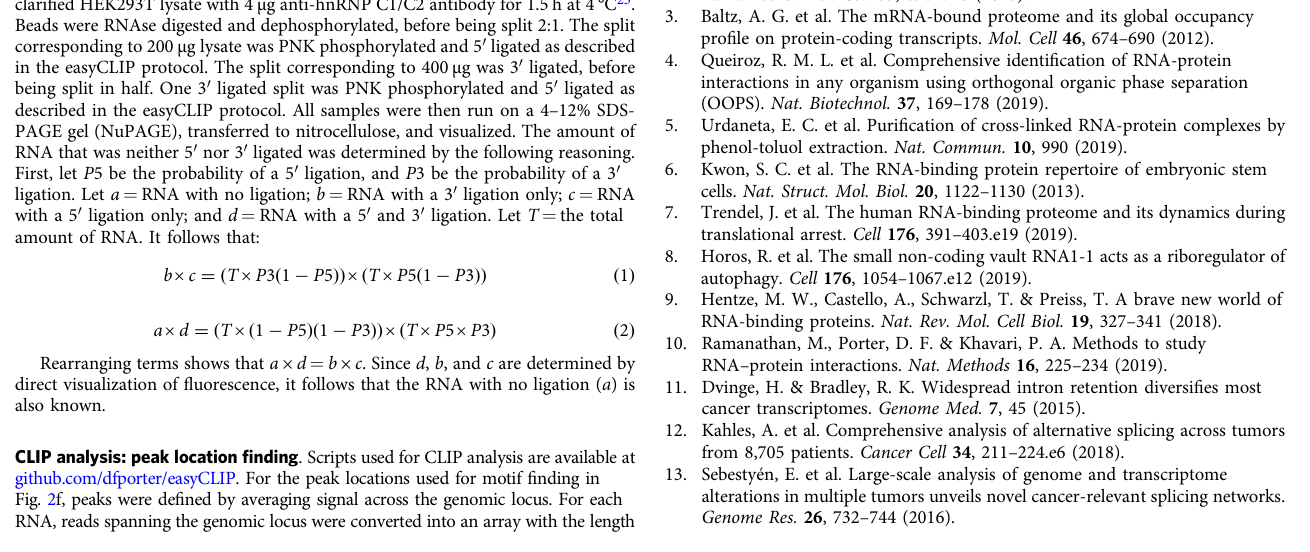
Fig. 2f, peaks were de fi ned by averaging signal across the genomic locus. For each RNA, reads spanning the genomic locus were converted into an array with the